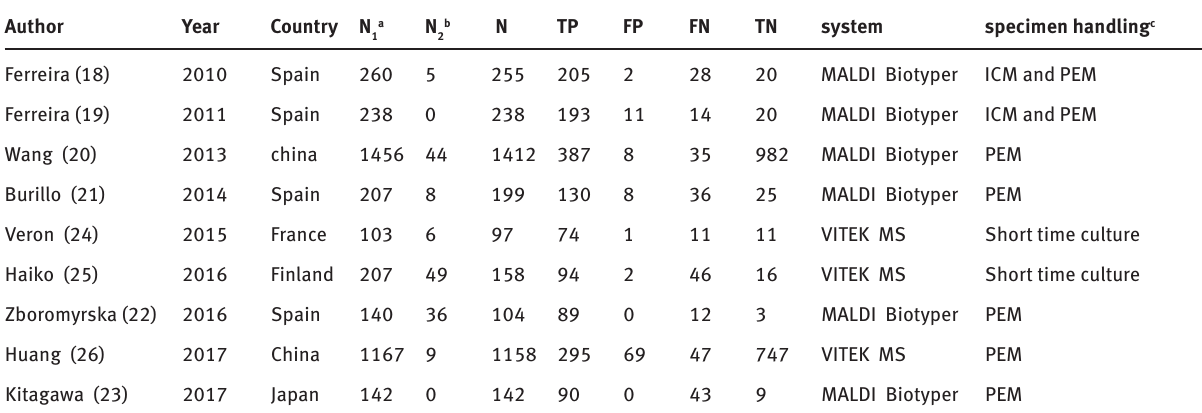
Table 1: Main characteristics of the enrolled studies